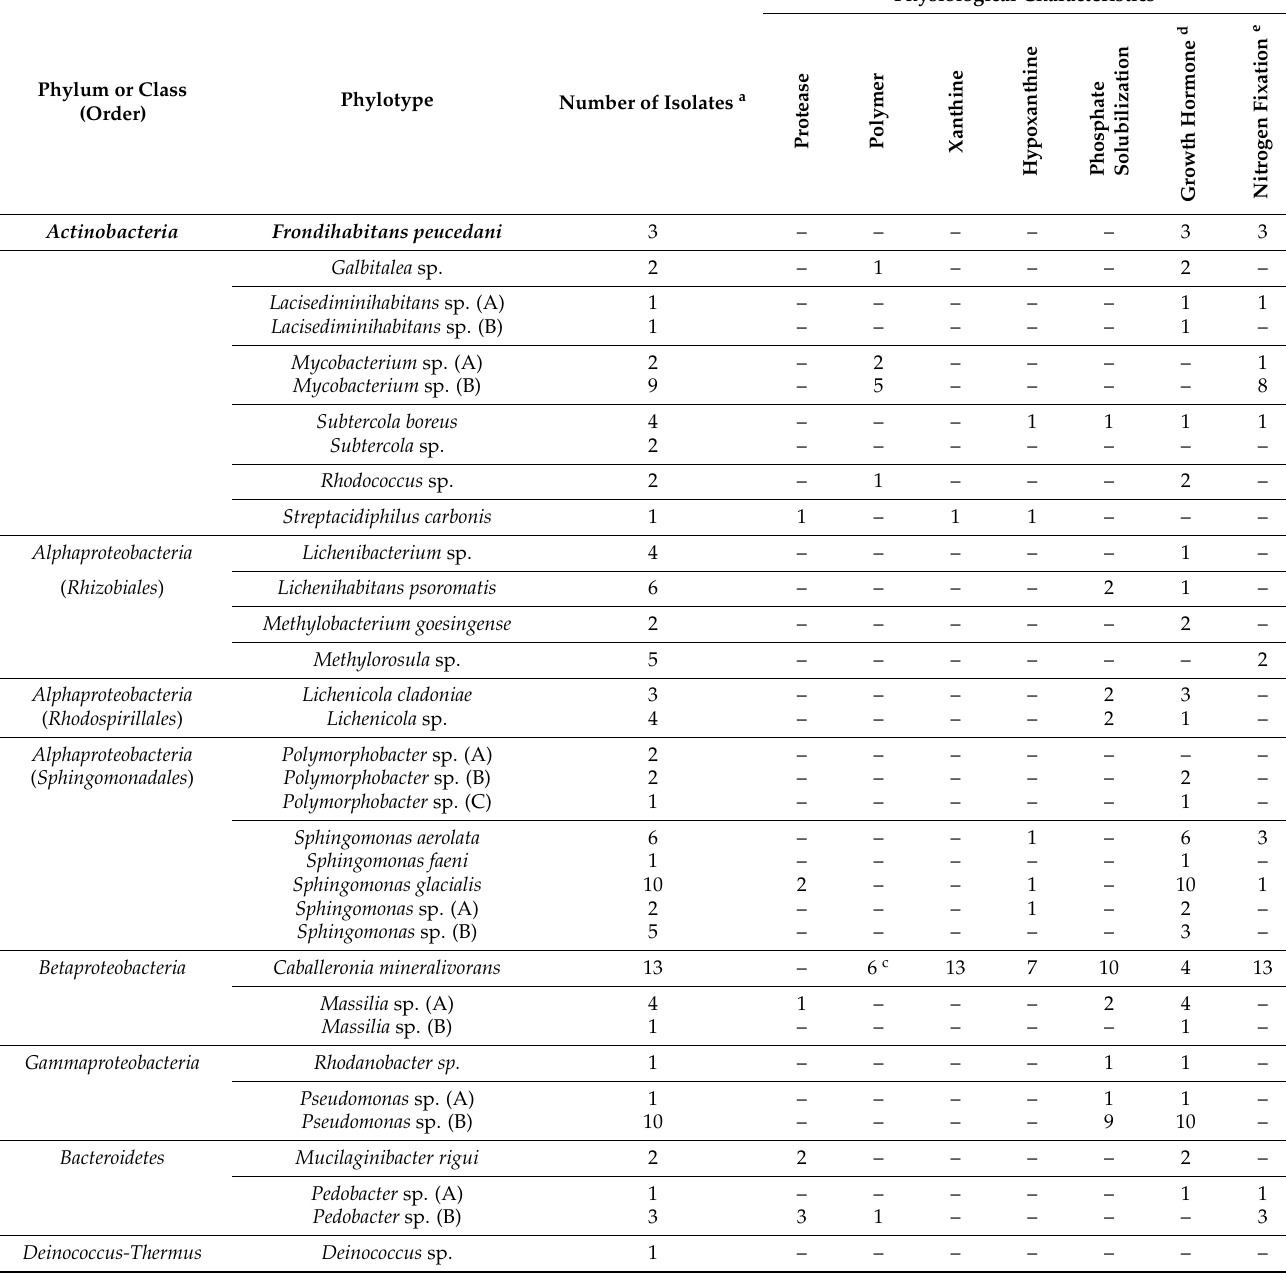
Table 3. Physiological